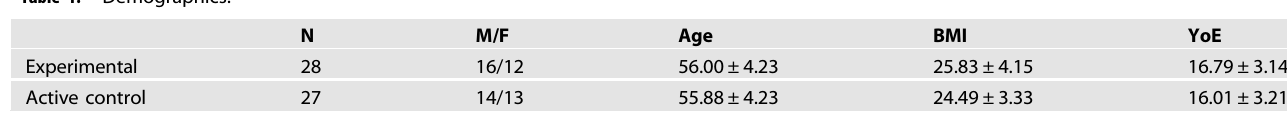
RESULTS Demographics Demographic characteristics of the participants are summarized in Table 1. There was no signi fi cant difference for age ( p = 0.92), sex ( p = 0.70), BMI ( p = 0.19), or years of education ( p = 0.38) between the experimental and the active control groups. Thus, no correction for these variables was applied [68]. Working memory training The experimental group showed signi fi cant practice effects both in verbal n -back training ( Z = 7, p = 8.07e − 6) and visual n -back training ( Z = 13, p = 1.51e − 05), Fig. 3A. It also showed a signi fi cant improvement in the n -back level achieved in verbal n -back training ( Z = 21, p = 3.34e − 05) and in visual n -back training ( Z = 18.5, p = 6.51e − 05), Fig. 3B. In the active control group, d prime did not signi fi cantly differ between the beginning and the end of verbal n -back training or visual n -back training. In the multivariate ANOVA, a signi fi cant group × time interaction was found only for the nearest transfer effect category (F (4,50) = 5.3, p < 0.013). Follow-up univariate analysis of variance revealed a signi fi cant group × time interaction for the Digit Span forward test, Table 2. The experimental group showed a signi fi cant improve- ment in the Digit Span forward test at T2 compared to T1, Table 3. Subjects in both groups showed quicker reaction times in the Visual Simon task (VST) at T2 compared to T1. Here, the experimental group improved in the incongruent trials (RT- incong), whereas the control group improved both in congruent and incongruent trials. Based on the Bayesian statistics, we found decisive evidence for nearest transfer effects to the forward digit span (BF 10 = 182.42). Strong evidence from simple-effects analysis suggests that this was driven by a change in the experimental group (BF 10 = 18.53) rather than in the control group (BF 10 = 1.87). There was relatively weak evidence against transfer to the Corsi task (BF 01 = 3.77). For near transfer, there was relatively weak evidence against transfer to the VLMT (BFs01: 2.75 – 3.66). For the RVIP, there was weak evidence against transfer in accuracy (BF 01 = 3.71), and ambig- uous evidence for transfer in RTs (BF 01 = 1.98). For all measures of the VST and Stroop task, there was at least ambiguous evidence in support of the null (all BFs 01 > 1.54). Finally, there was ambiguous evidence against transfer to the short-APM (BF 01 = 1.78) and weak evidence against transfer in the Iowa Gambling Task (BF 01 = 3.99). Voxel-wise analyses of the ALFF and PET data The group × time interaction was not signi fi cant in both analyses. Explorative analyses with uncorrected thresholds ( p < 0.001, k > 50 voxels) are shown in Supplemental Fig. S1. In brief, there were no plausible fi ndings. Network analyses of the resting state fMRI and PET data Figure 4 shows the RSNs of interest as extracted from the fMRI and PET data. ANOVAs revealed no signi fi cant group × time